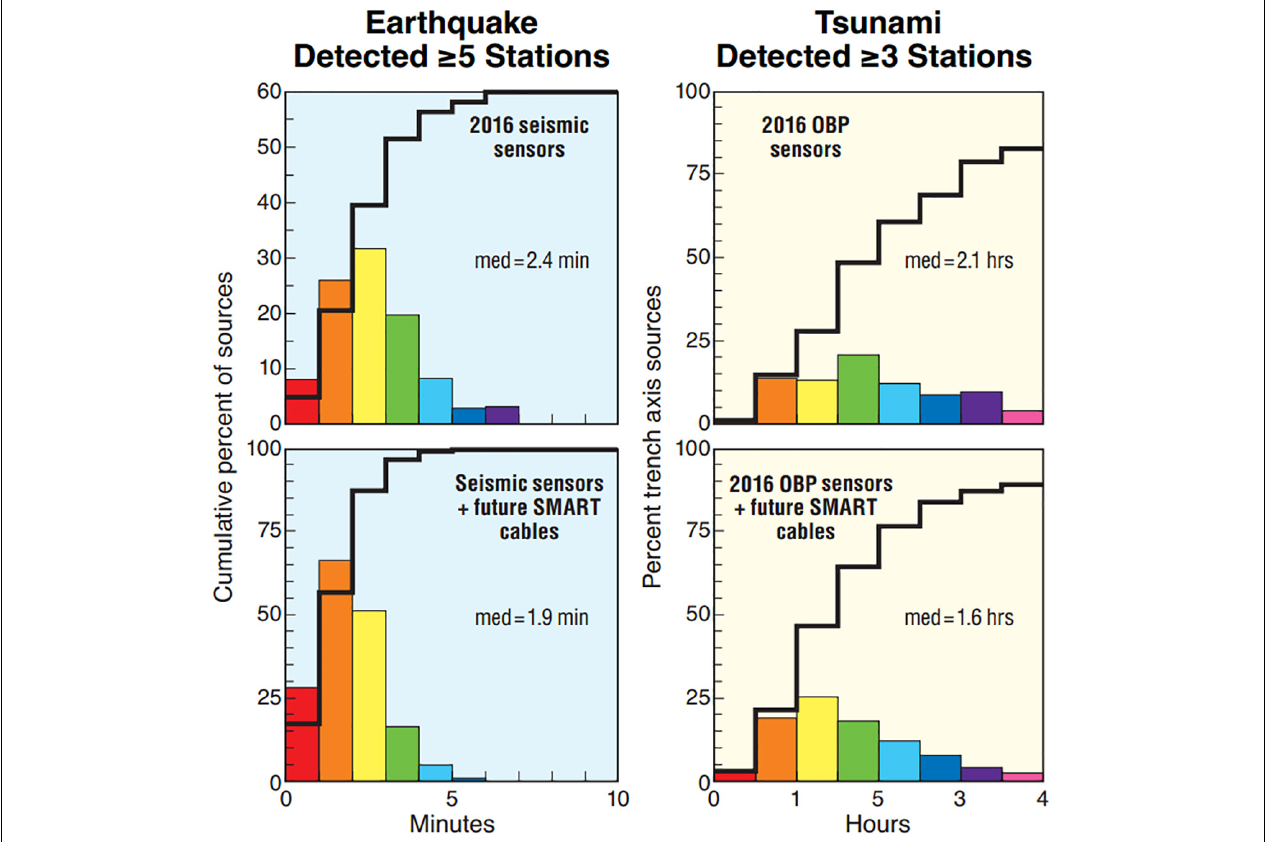
FIGURE 10 | Comparing time statistics for cases without (top row) and with SMART sensors (bottom row). Left column: ≥ 5-Station P-wave reception time with azimuthal gap < 180 ◦ , for trench axis sources. Right column: Time to detect and transmit tsunami data, for OBP signals detected. Permission obtained for use